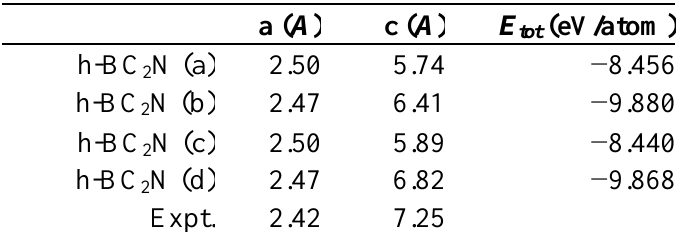
Table 1. Cell structure and calculated total energy of hexagonal BC Experimental values from